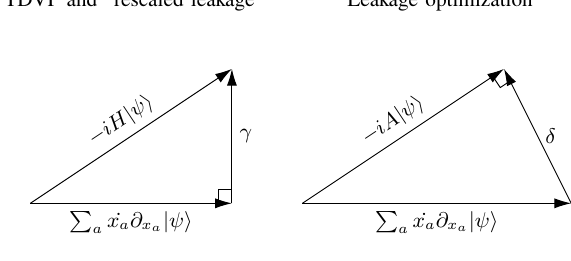
FIG. 6. Schematic representation of the difference between TDVP and leakage minimization. Because of the similar nature of optimization in both cases, one gets a right angle opposite